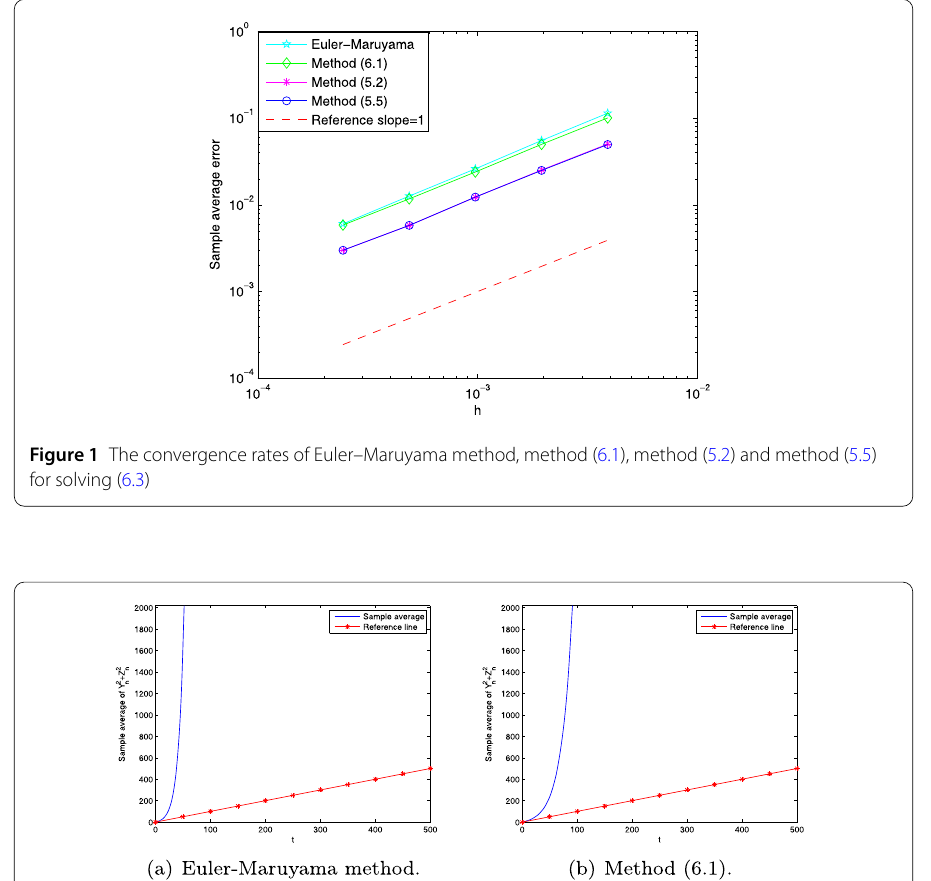
Figure 2 Linear growth property of second moment for Eq. (6.3)